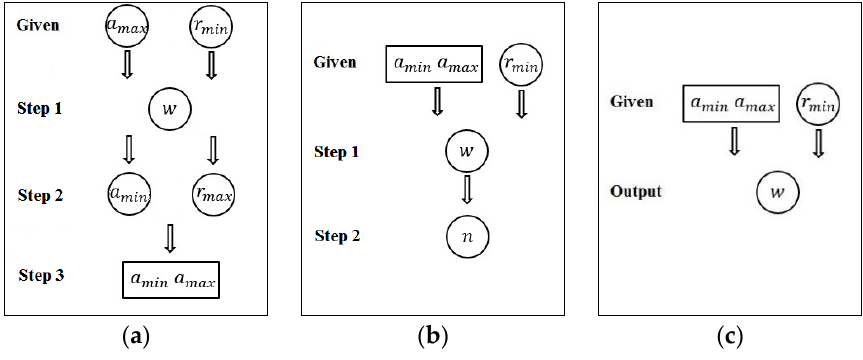
Figure 3. Control of key parameters: ( a ) method in [7]; ( b ) method in [8]; ( c ) our method.